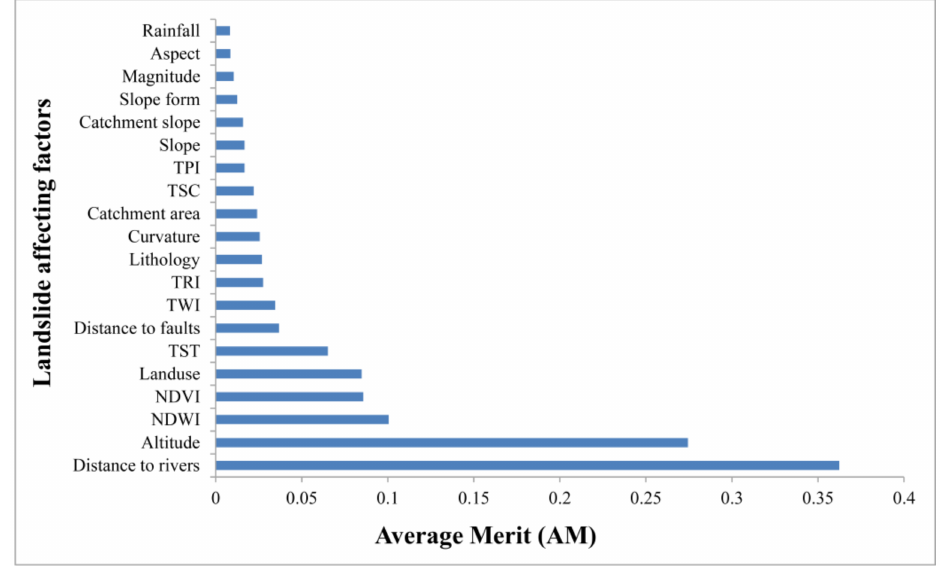
Figure 3. Average merit (AM) values for the landslide conditioning